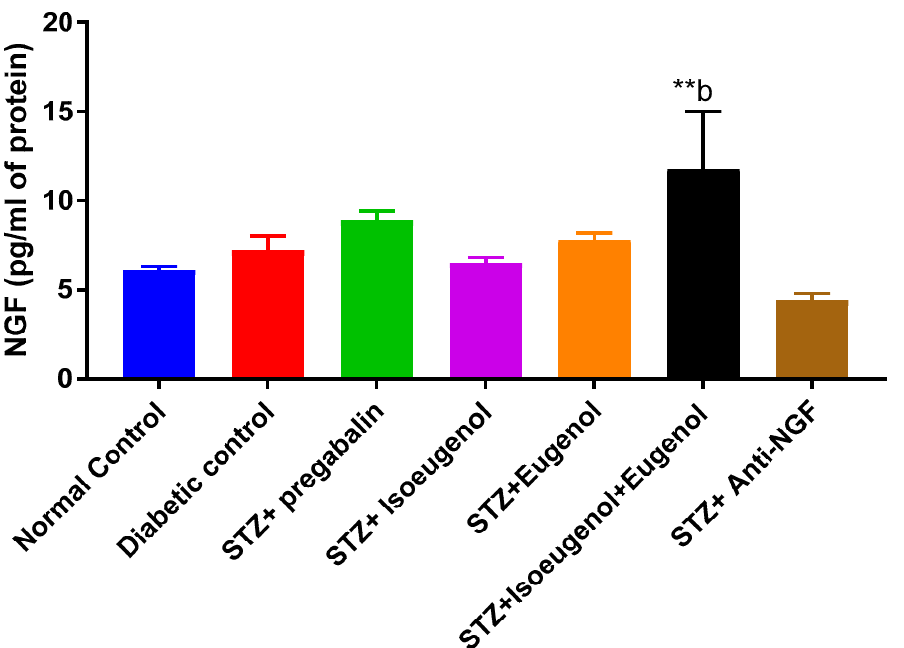
Figure 6. Effect of isoeugenol, eugenol, and their combination on NGF levels. A p < value of 0.05 Figure 6. E ff ect of isoeugenol, eugenol, and their combination on NGF levels . A p < value of 0.05 was considered statistically signi fi cant. Signi fi cance is represented as ** p < 0.01; b—diabetic control ver- was considered statistically significant. Significance is represented as ** p < 0.01; b—diabetic control sus treatment groups. NGF — nerve growth factor. versus treatment groups. NGF—nerve growth